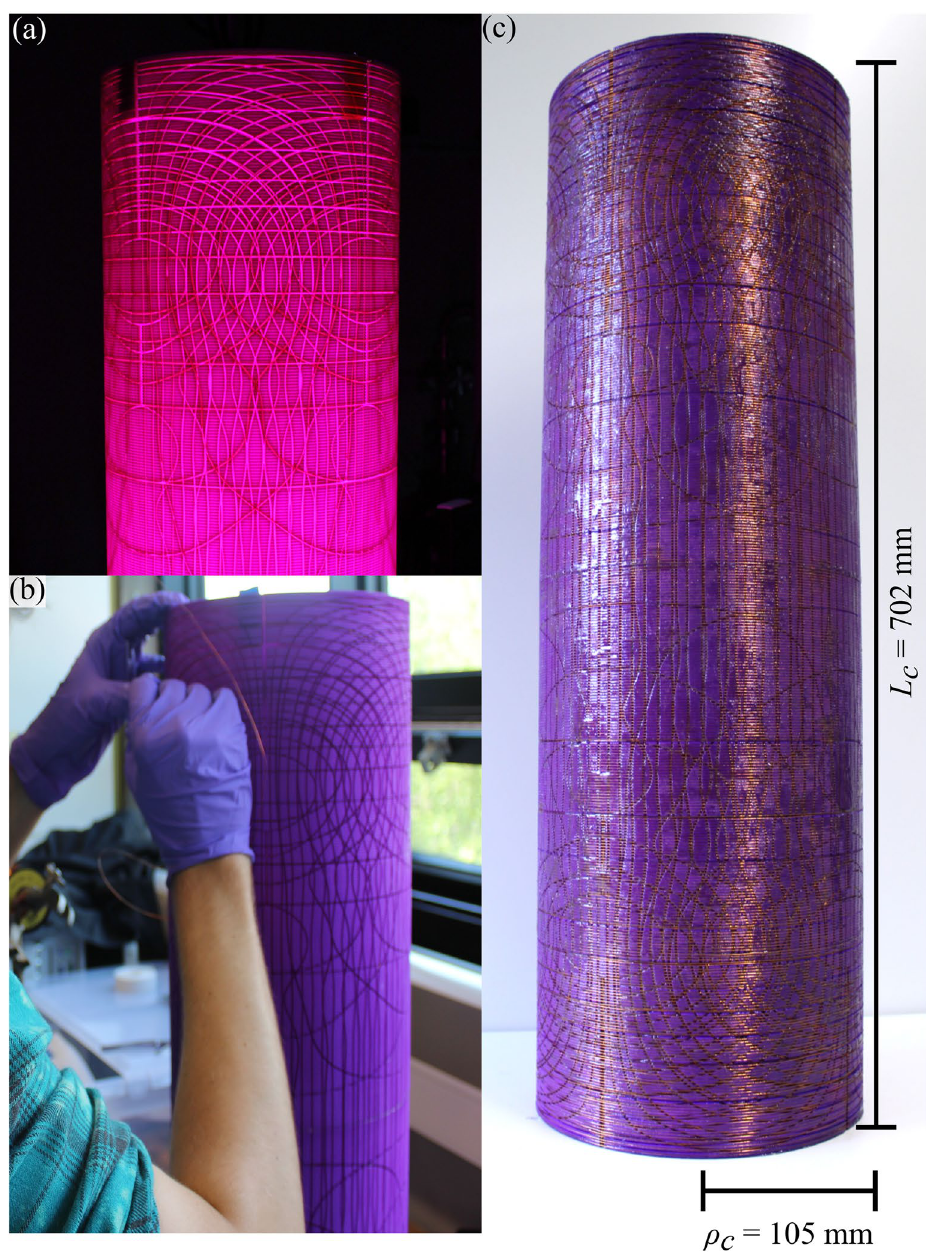
Figure 3. The 3D-printed coil former ( a ) before, ( b ) during, and ( c ) after